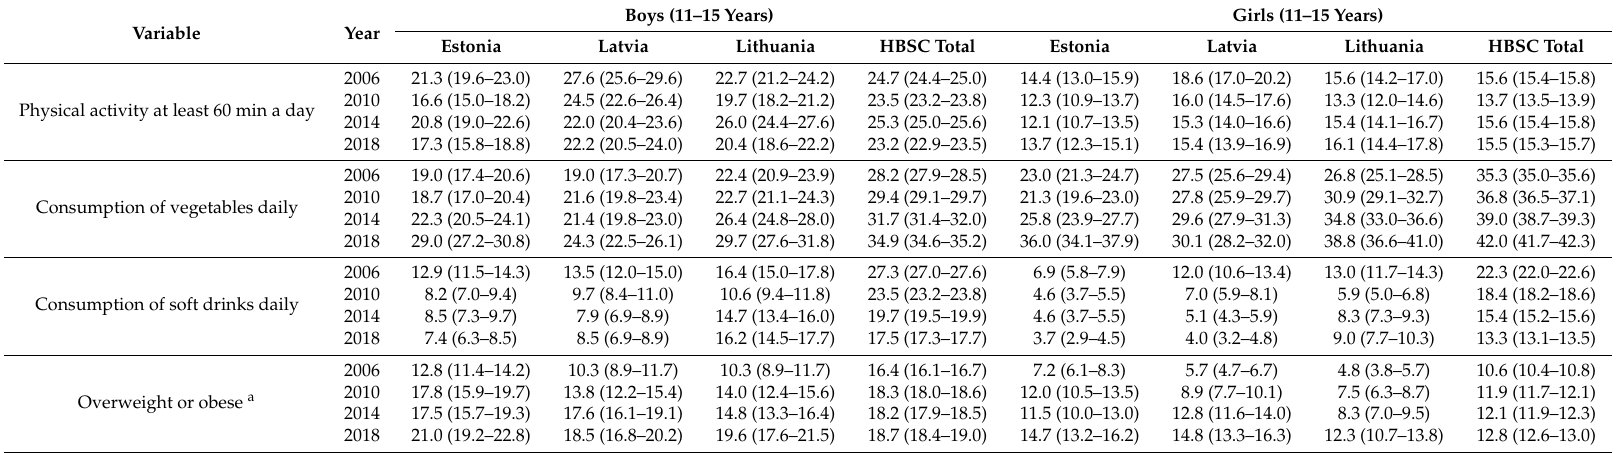
Table 2. Prevalence of the health-related variables by country, survey year and gender (percentage and 95% confidence